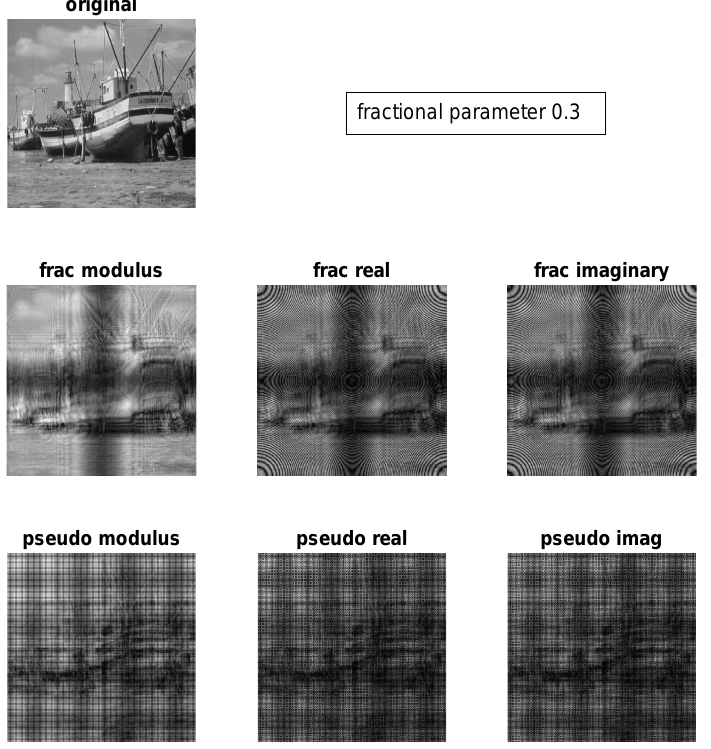
Figure 6. Comparison of DFrFT and DPFrFT of the grayscale image “Boat” for fractional parameter a =